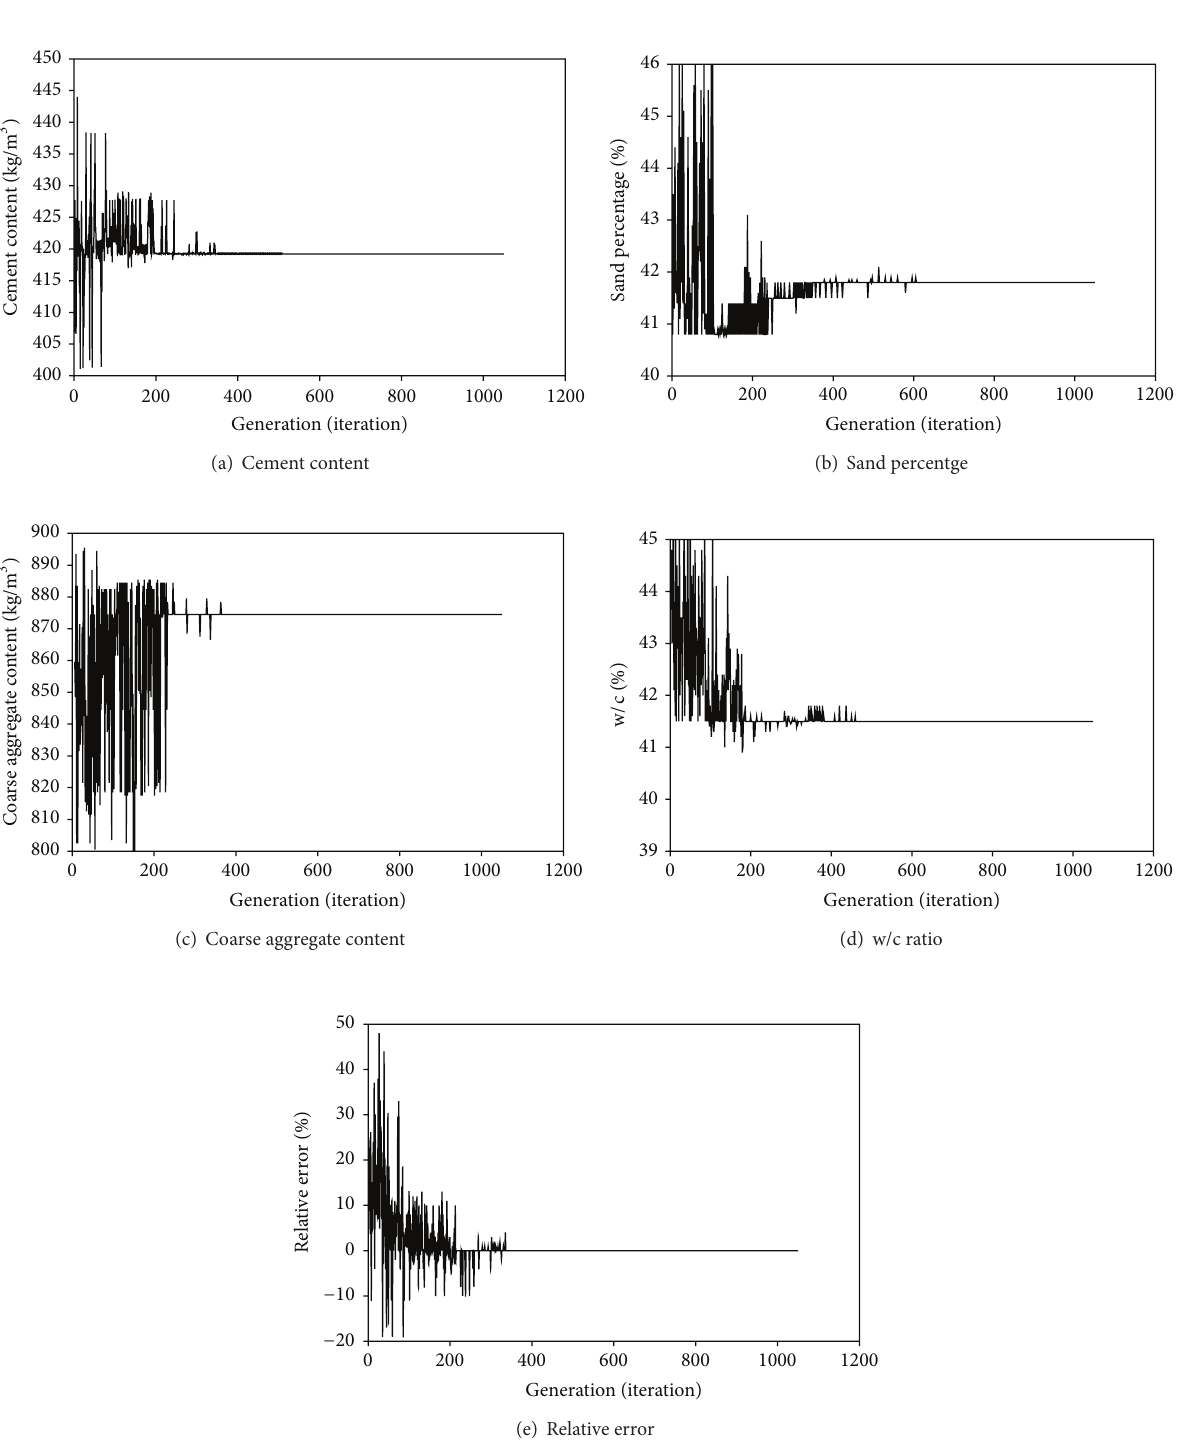
Figure 7: Simulated process through GA (w/c 0.42 and R.H.